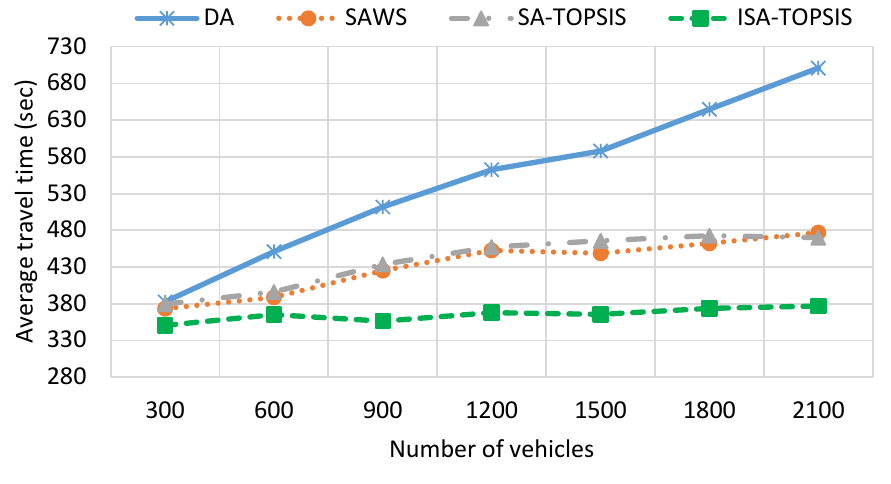
Figure 7. Average travel